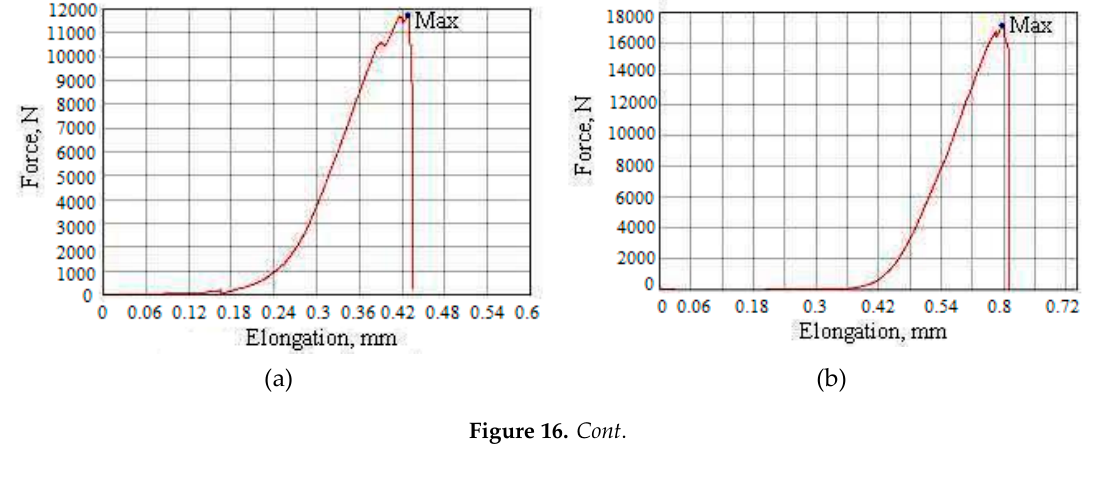
Figure 15. Strength tests of samples of compacted SiO 2 nanopowder: ( a ) Shimadzu tester; ( b ) sample of compacted nanopowder; ( c ) sample before